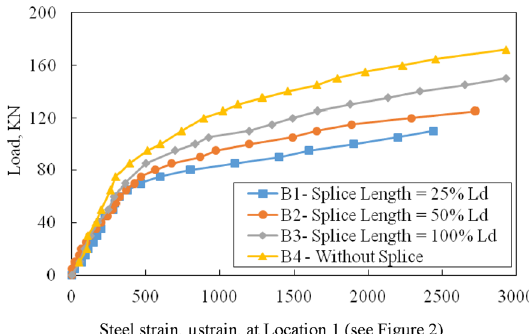
Fig. 10 Load–longitudinal steel strain of Beams B1, B2, B3 and B4